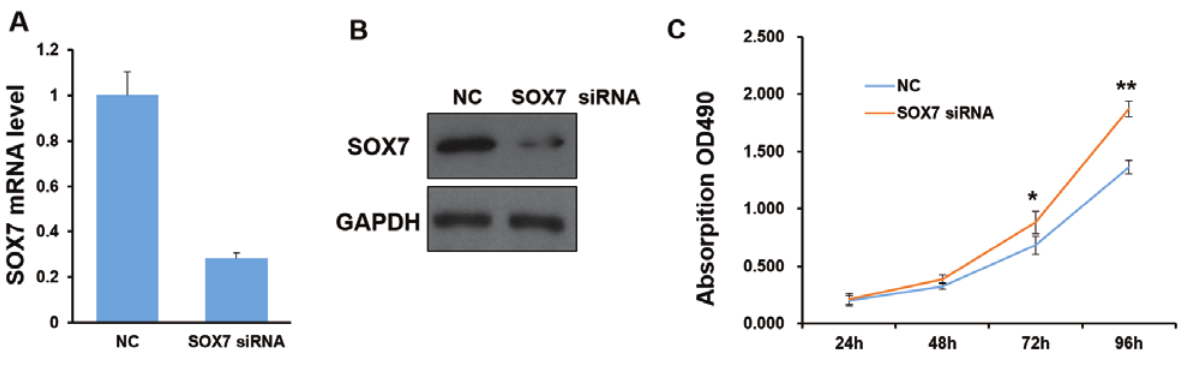
Figure 2 : Knockdown of SOX7 promotes U87 cell proliferation. U87 cells were transfected with SOX7 siRNA or control siRNA. After 48h, cells were harvested for qPCR test (A) and western boltting (B). (C) U87 cells were transfected with SOX7 siRNA or control siRNA. In the indicated